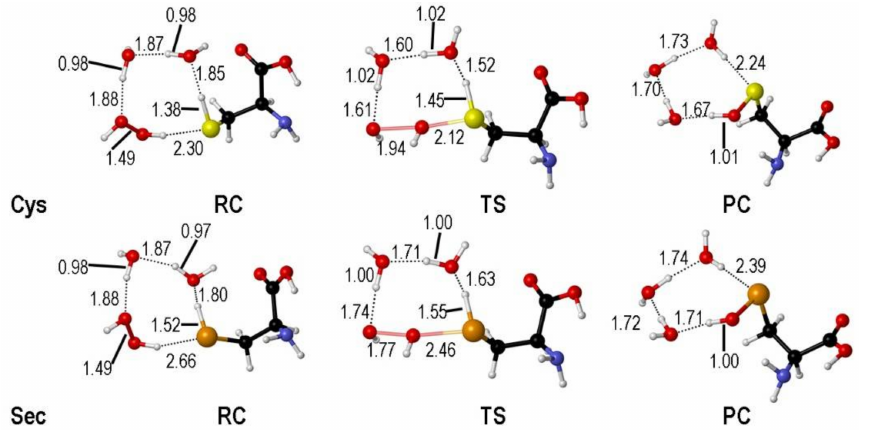
Figure 2. Stationary points along the water assisted oxidation mechanism of Cys/Sec by H 2 O 2 (see Scheme 11). Relevant interatomic distances are shown in Å. Adaped from [38].